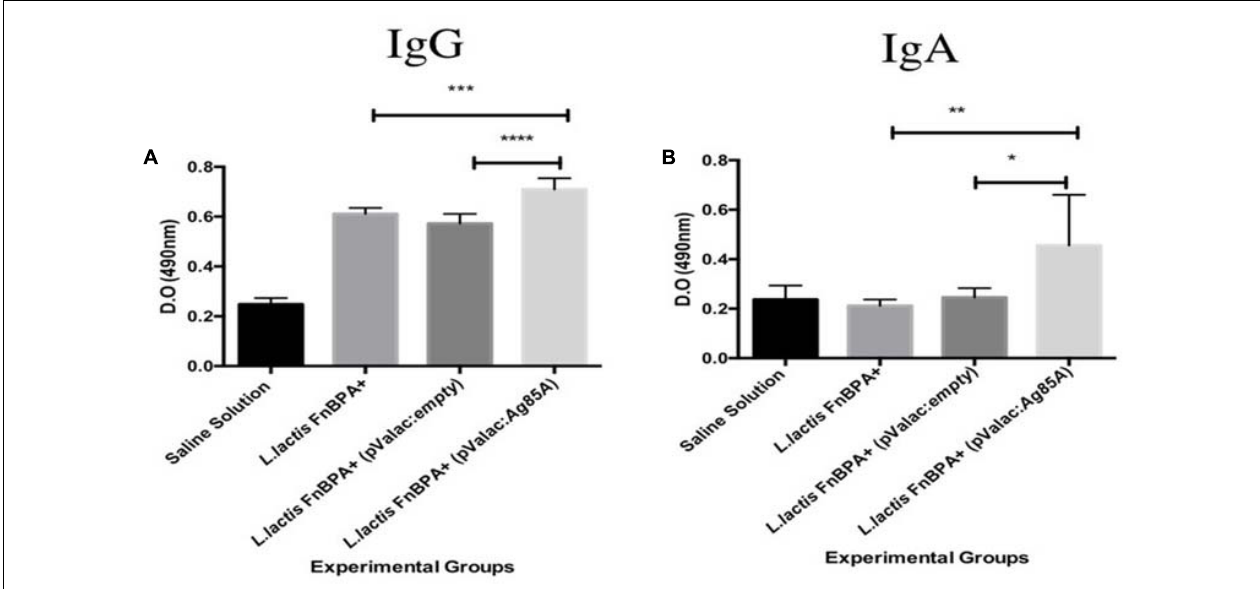
FIGURE 5 | Antibodies production in serum of mice intranasally immunize. Production levels of (A) IgG anti-Ag85A and (B) IgA anti-Ag85A in serum of mice after 2 weeks of the last immunization. Experimental groups: Saline Solution (negative control), L. lactis FnBPA + (negative control), L. lactis FnBPA + (pValac: empty ), and L. lactis FnBPA (pValac: Ag85A ). Data are shown as the mean ± SD. Two individual experiments were performed, five animals were used in each group for each individual protocol and each animal was analyzed individually. p -value: ∗ p < 0.05, ∗∗ p < 0.01, ∗∗∗ , p < 0.001, and ∗∗∗∗ p < 0.0001.